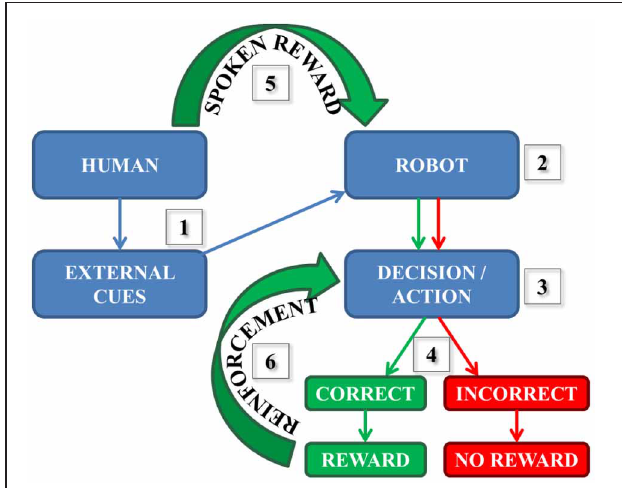
FIGURE 1 | Simplified reward-based learning scheme during human-robot interaction. (1) The external cue is presented by the human to the robot; (2) The information is seen and processed by the robot; (3) The decision and the related action are performed; (4) The robot chose the ball correctly or incorrectly; (5) The spoken reward (if correct action) is received by the robot (6) The reward reinforces Learning every time the decision is